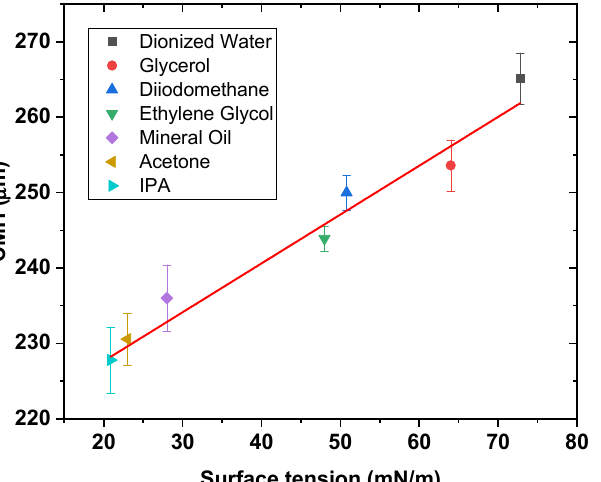
Figure 2. Depiction of the critical meniscus height ( CMH ) in response to variation in the surface tension of the liquid.